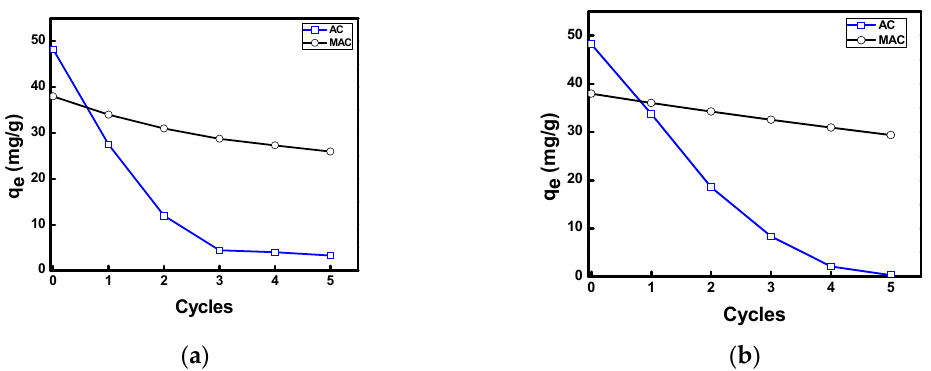
Figure 9. Equilibrium adsorption of 2,4-D onto AC and MAC adsorbents after ( a ) chemical and ( b ) thermal regeneration processes.